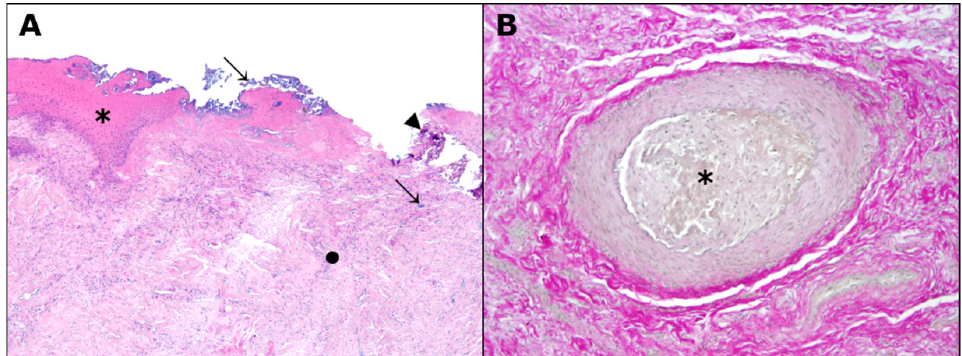
Figure 4. Cutaneous pathohistological findings in coypus. Severe extensive chronic ulcerative to sup- purative dermatitis with superficial bacterial colonies (arrows) and intralesional dystrophic minerali- zation (arrowead). Note the reactive peripheral epidermal hyperplasia (asterisk) and the underlying granulation tissue (black dot), hematoxylin and eosin ( A ). Magnification 40 × . Medium-sized cutane- ous arterial vessel with thrombus (asterisk), elastica van Gieson ( B ). Magnification 100 ×